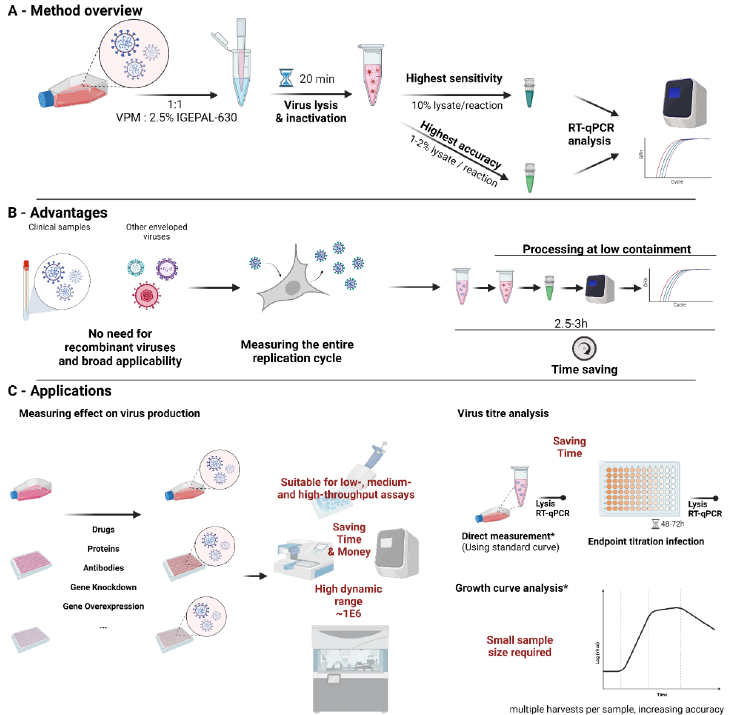
Figure 4. Direct lysis RT-qPCR method. ( A ) depicts an overview for using the method. ( B ) highlights the advantages of using direct lysis RT-qPCR. ( C ) shows applications for which direct lysis was successfully used and suggestions for other applications. * Direct measurement of virus titers may not accurately represent infectious virus dependent on harvesting time and conditions. Similarly, growth curves at later points of infection may not accurately represent infectious virus particles present in the solution. Created with https://biorender.com/ (accessed on 1 January 2022)